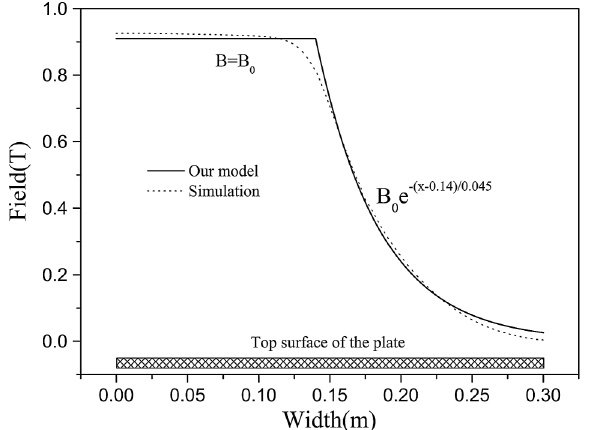
FIG. 9. A SS plate of dimension ð 0 : 3 ; 0 : 1 ; 0 : 002 Þ m 3 is exposed to a space dependent time varying magnetic field. The eddy current generated by such an asymmetric field will be evaluated.